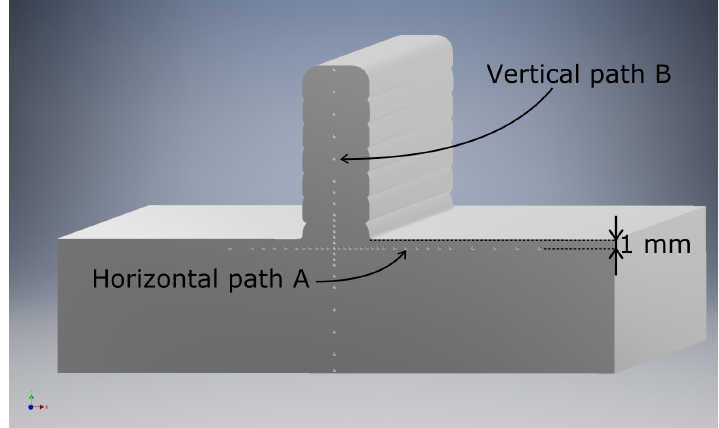
Figure 2. Scheme of the horizontal (A) and vertical (B) hardness